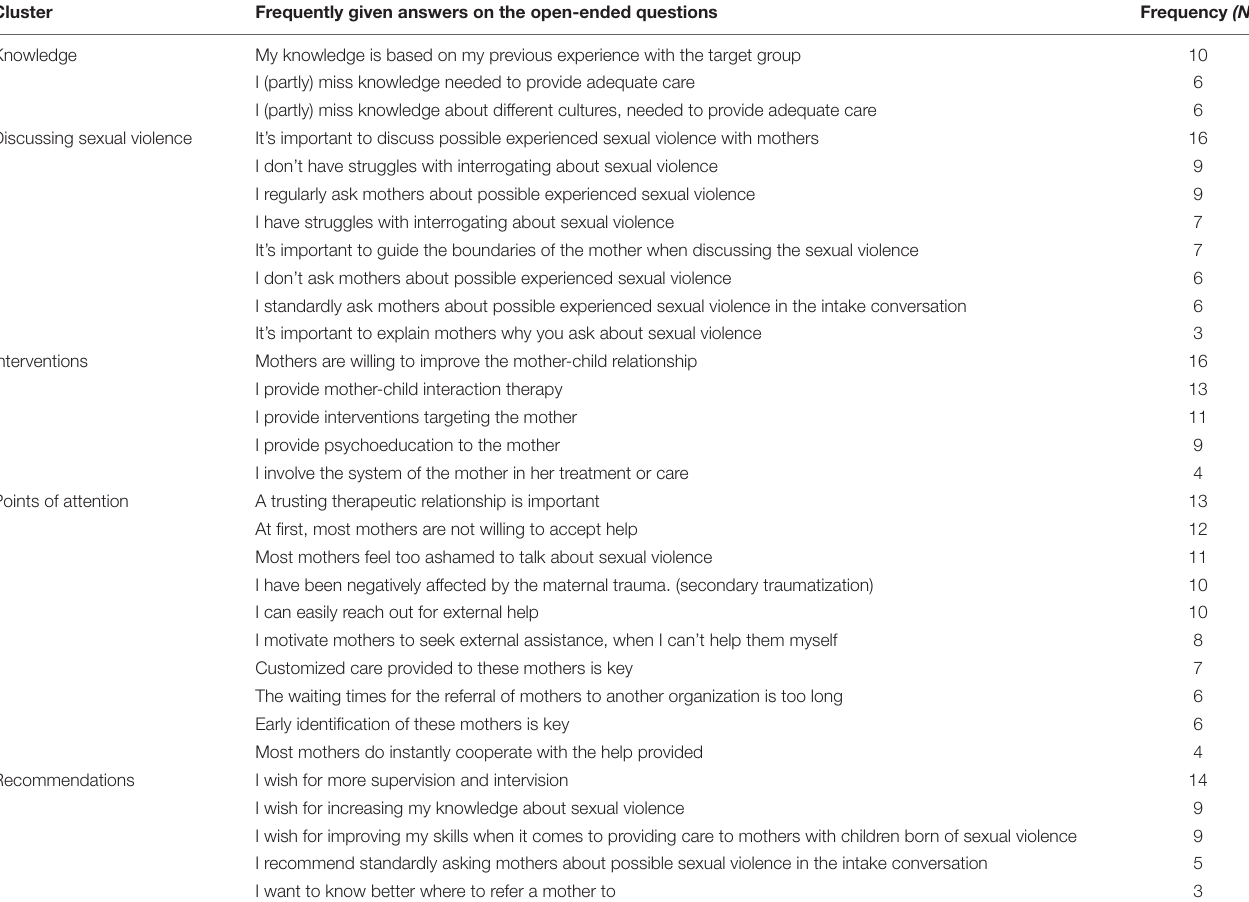
TABLE 1 | Quantitative overview of the results. Cluster Frequently given answers on the open-ended